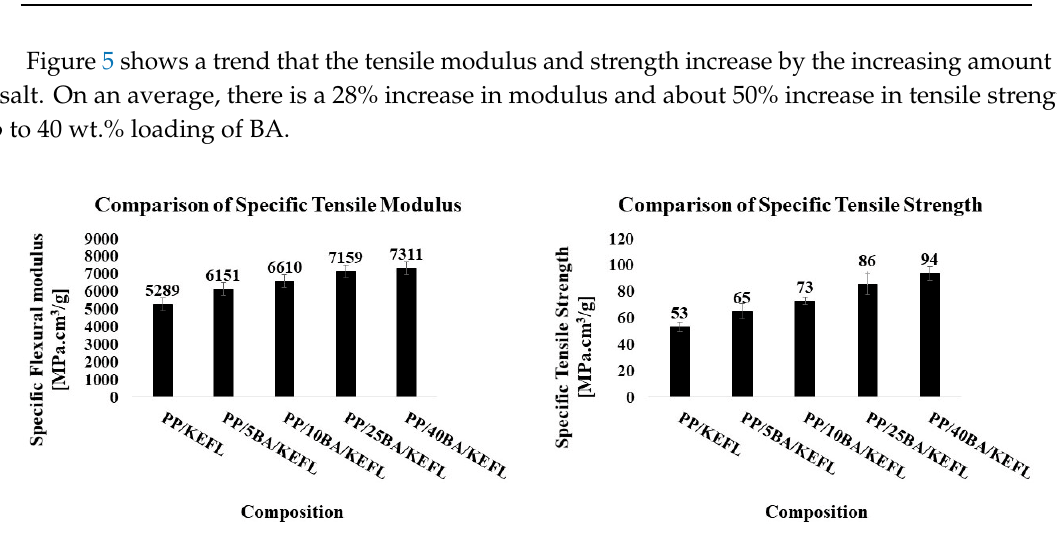
Figure 5. Tensile analysis of PP composites with bast and hybrid bast/BA fibers.